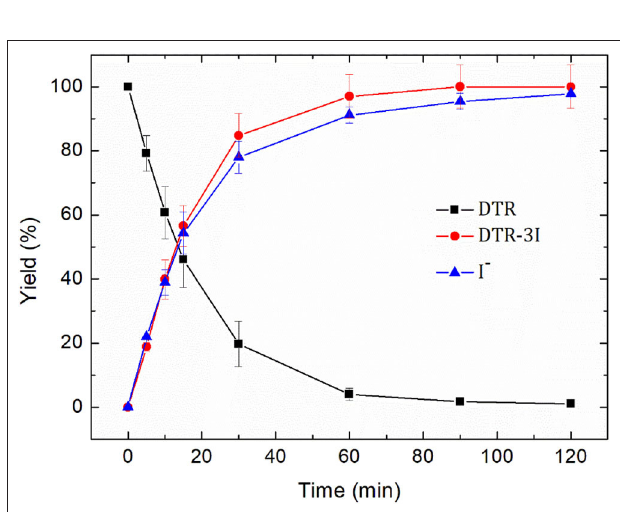
FIGURE 6 | Removal yield of diatrizoate (DTR), yield of 3,5-diacetamidobenzoic acid (DTR-3I) and deiodination yield (I − ) during electroreduction of diatrizoate (100mg L − 1 ) at − 1.3 V/SCE.